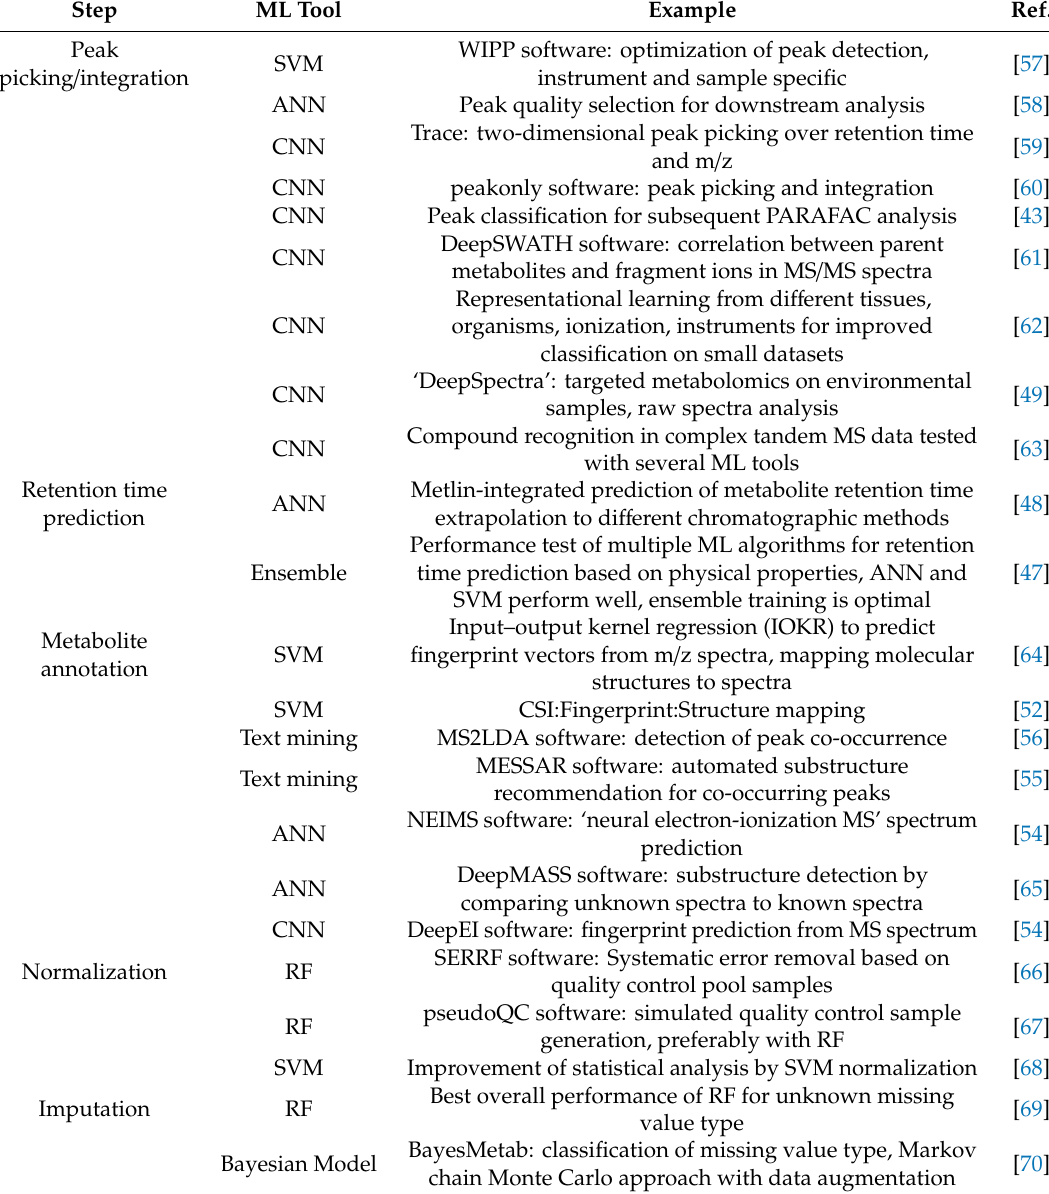
Table 3. ML tools for data processing since